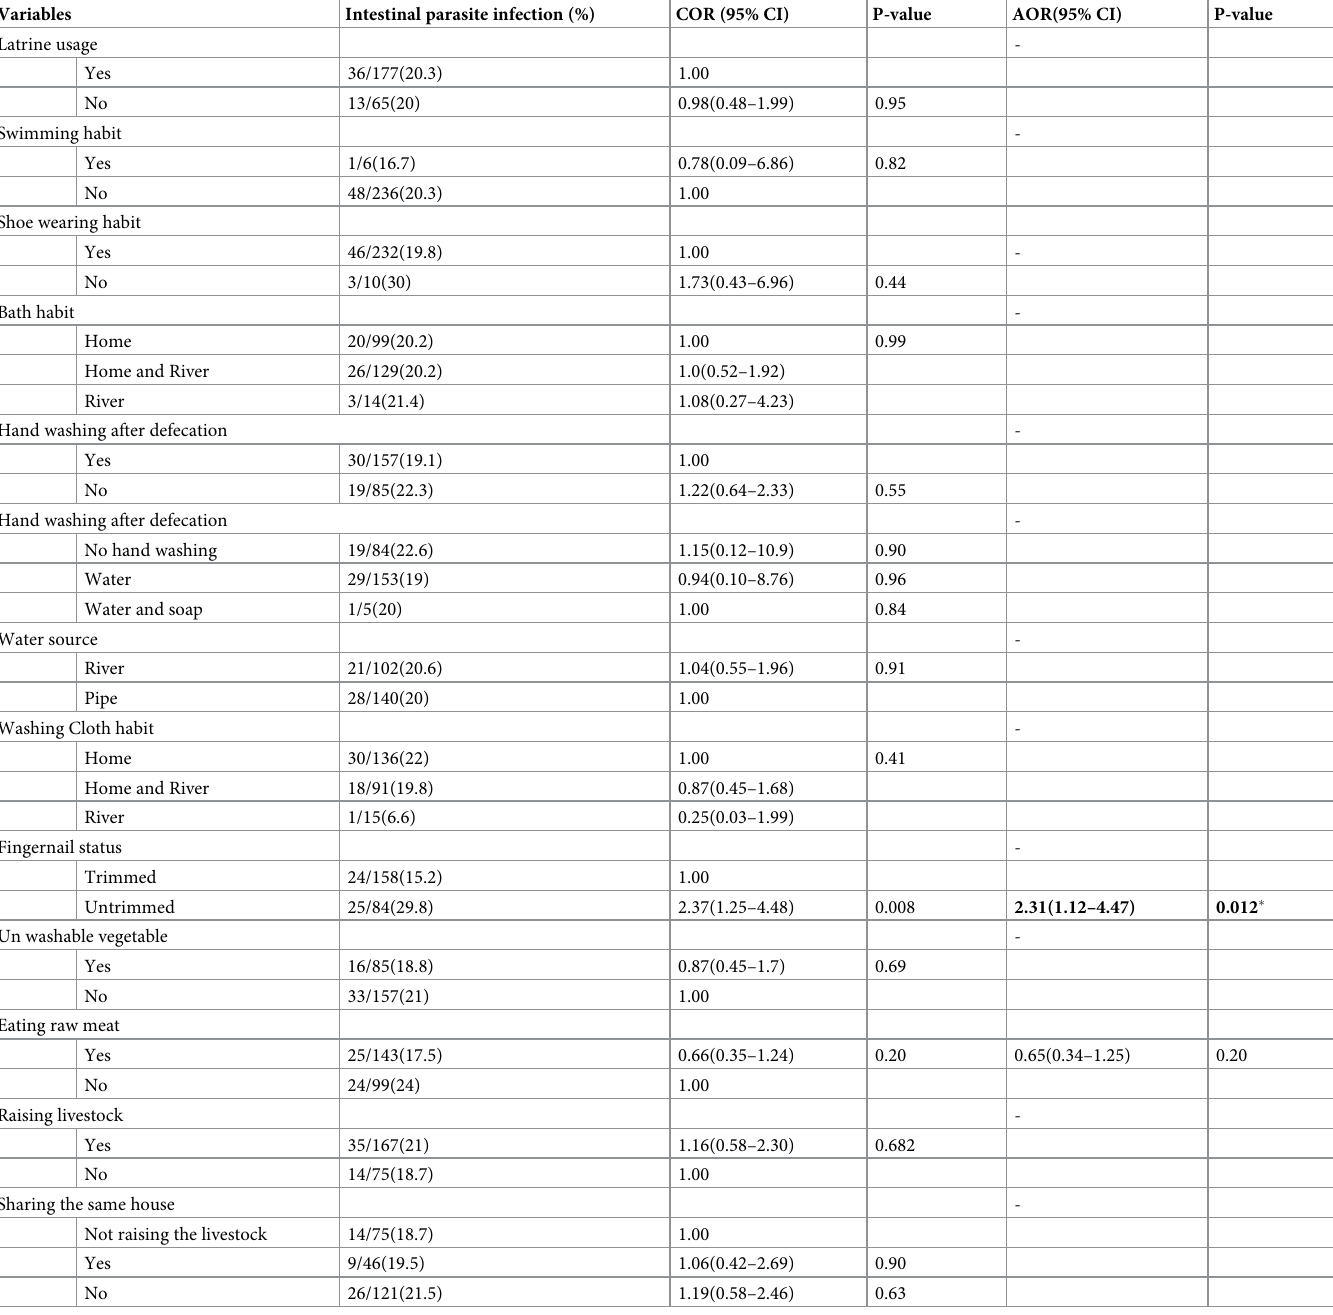
Table 4. Associated factors for intestinal parasitosis among PTB suspected patients attending Kuyu General Hospital, North Shewa, Oromia, Ethiopia, 2020 (n = 242).